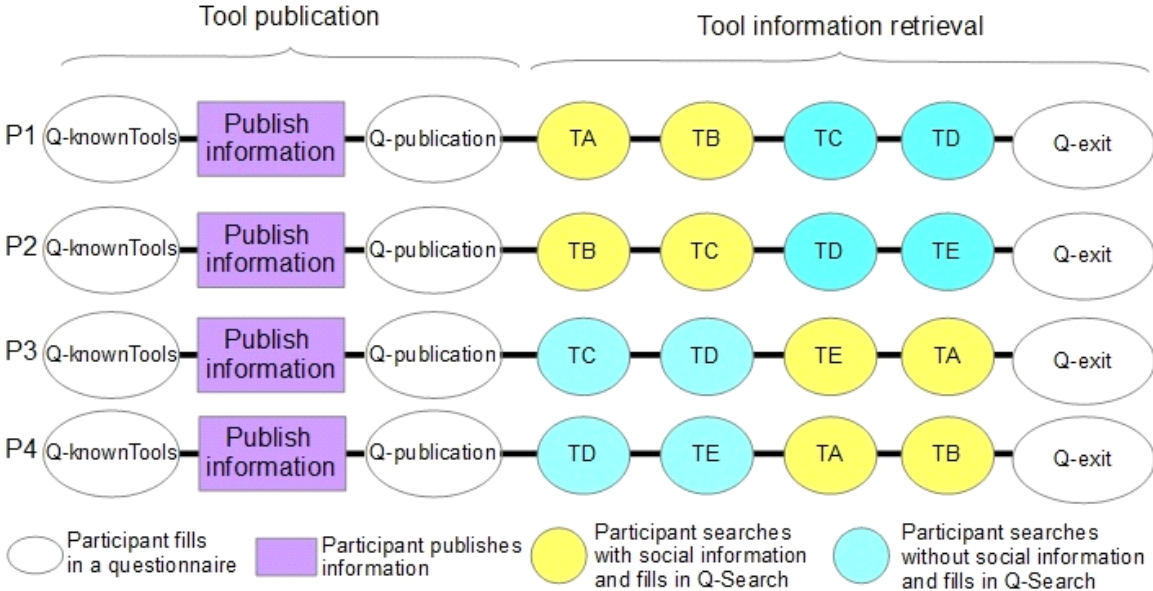
Figure 5. Graphical representation of the tasks carried out by four of the participants of the evaluation.